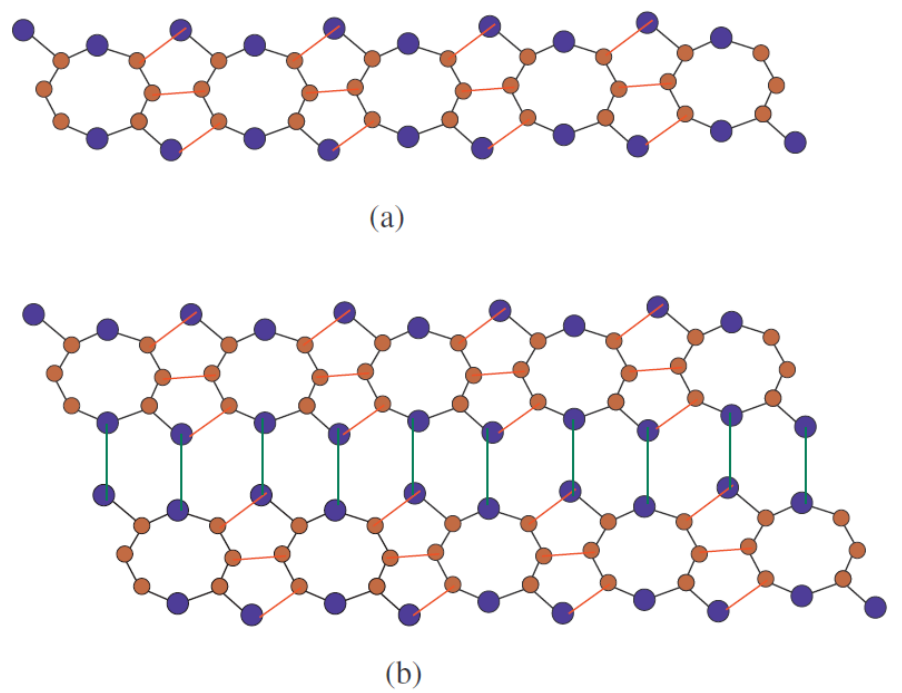
Figure 1: Two dimensional constitution of Si (a) One dimensional cell of Si (b) Si C - III [5,4]. Brown vertices as Carbon atom C and blue vertices as Silicon atom Si . 2 3